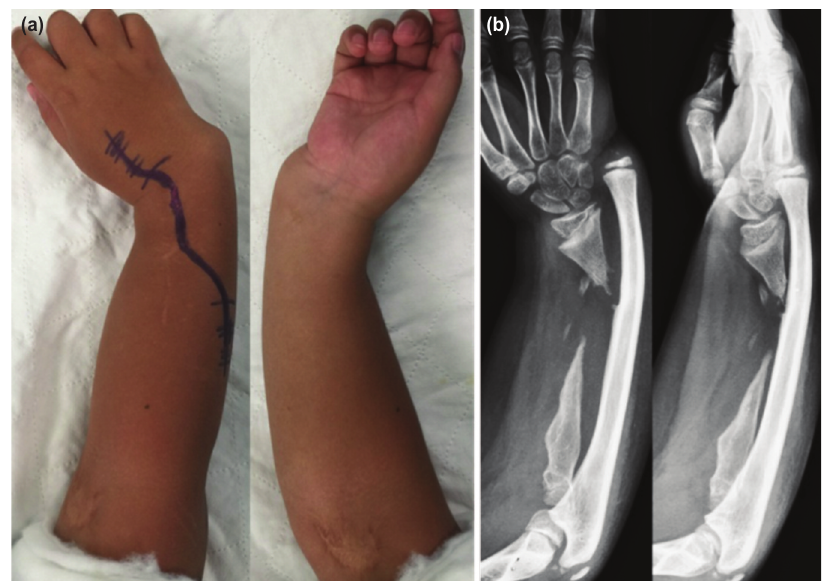
(a) Pre-operative photograph of the child showing radial clubhand deformity. (b) Radiographs showing loss of diaphysis of the Fig. 1: right radius, intact epiphysis and hypoplastic radial head.